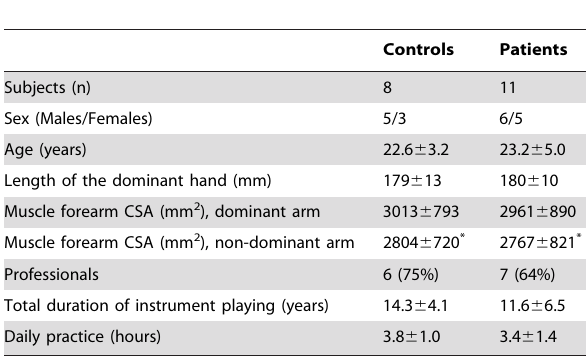
Table 1. Descriptive data of subjects included in the